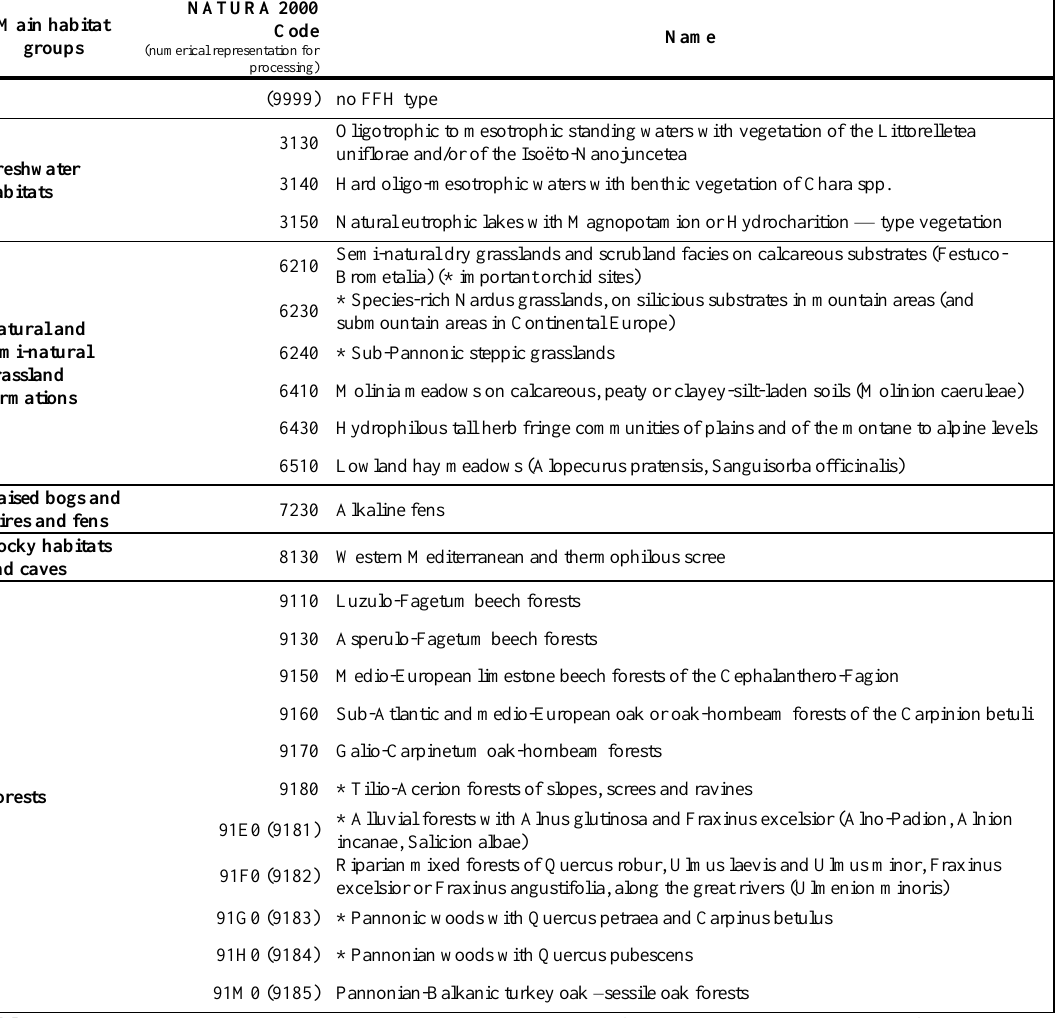
Table 1 . FFH types occurring in the research areas in the municipality of Vienna, according to Annex I of the European Union's Council Directive 2006/105/EC natural habitat types of community interest, whose conservation requires the designation of special areas of conservation, see European Commission (2006). The sign * prior to the name indicates priority habitat types. (Stadt Wien – https://data.wien.gv.at,